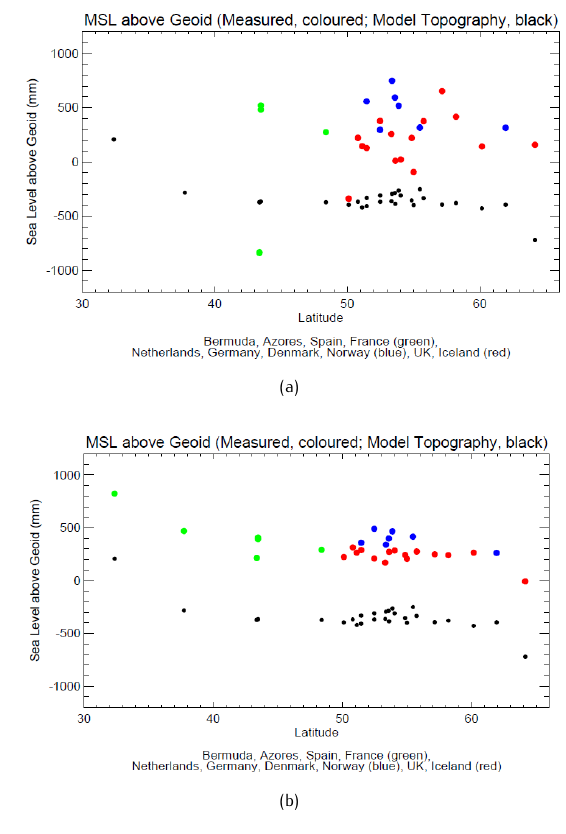
Figure 6. (a) Geocentric MSL relative to GOCO03S for stations in Iceland, along the Atlantic coast of Europe, and for Atlantic islandsplottedasafunctionoflatitude. Blackdotsfromthe same ocean model as in Figure 2. Coloured data points for Bermuda and Azores are outside the plot area. (b) Geocentric MSL relative to the Extended GOCO03S geoid